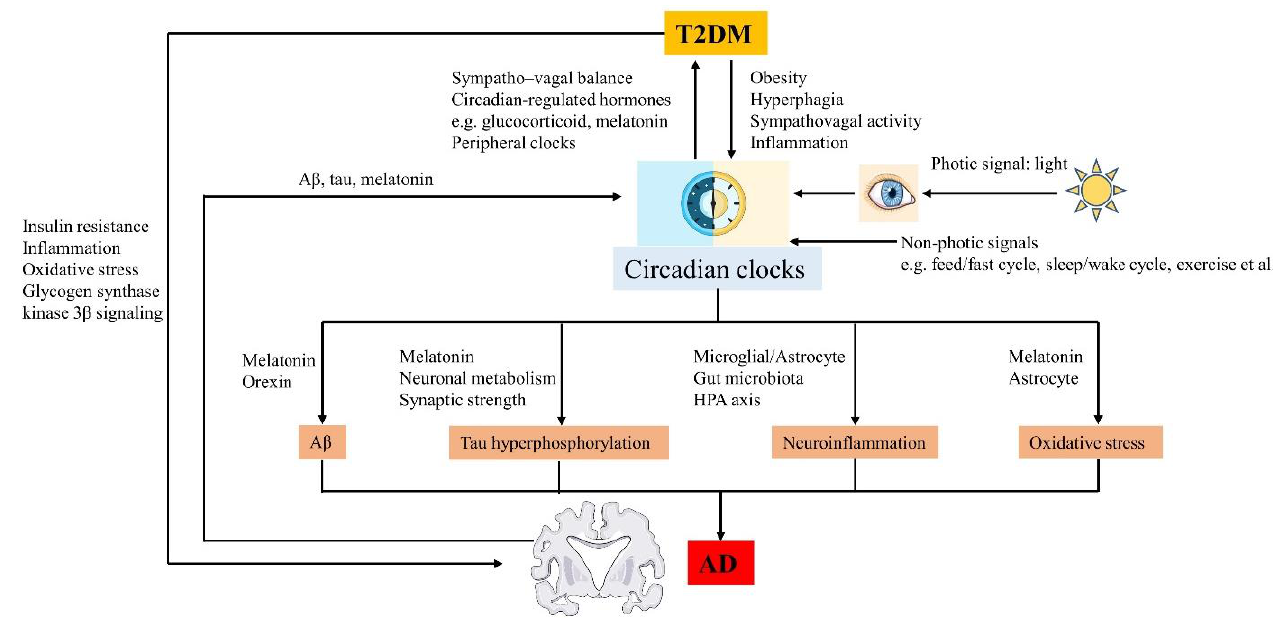
Figure 2. The circadian rhythms, T2DM and AD interact with each other.